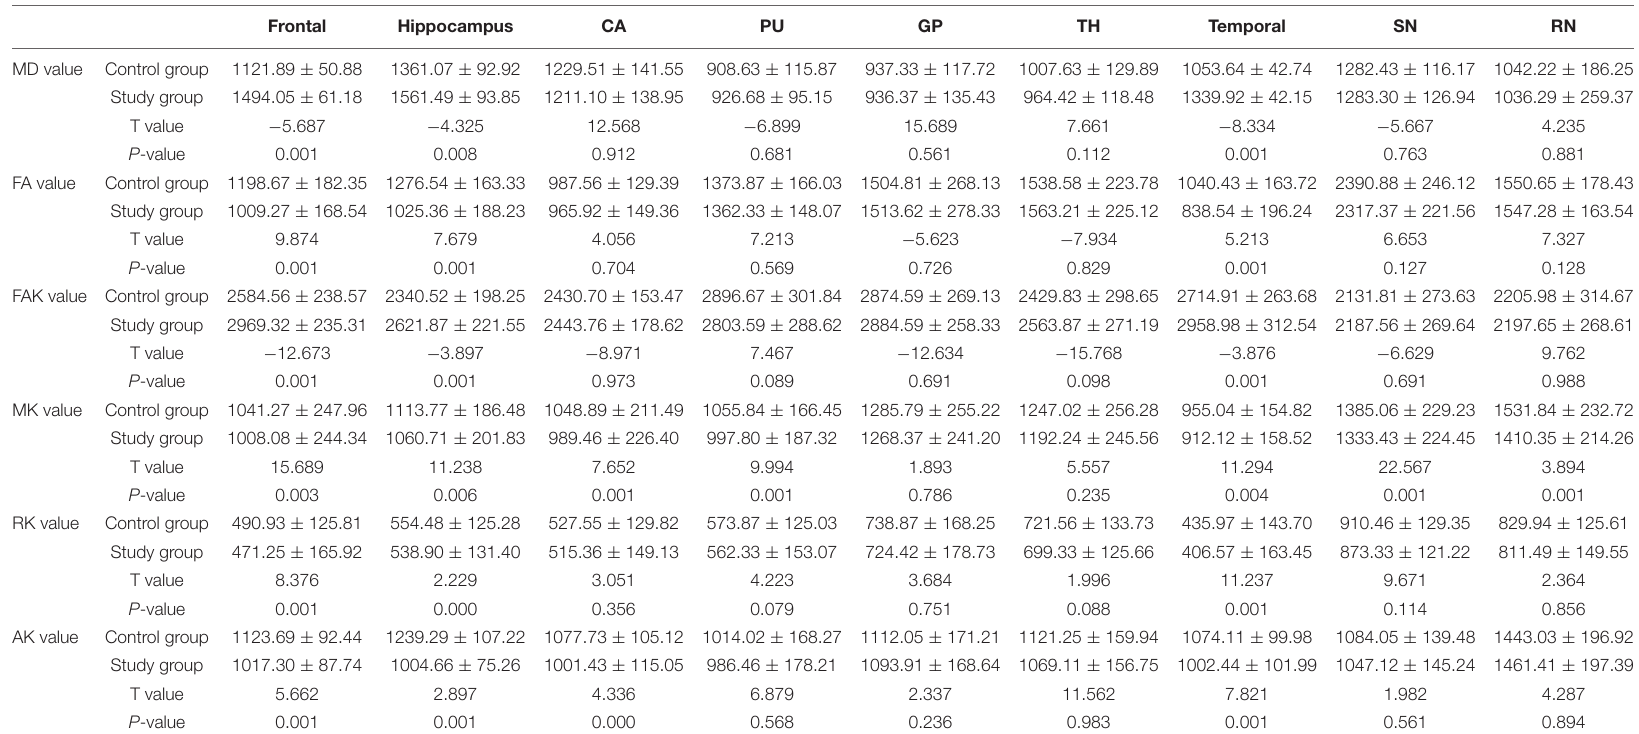
TABLE 2 | Comparison of the diffusion kurtosis imaging results between the study and control groups [10 − 4 µ m 2 /ms , x ± s, n = 60]. Frontal Hippocampus CA PU GP TH Temporal SN RN MD value Control group 1121.89 ±